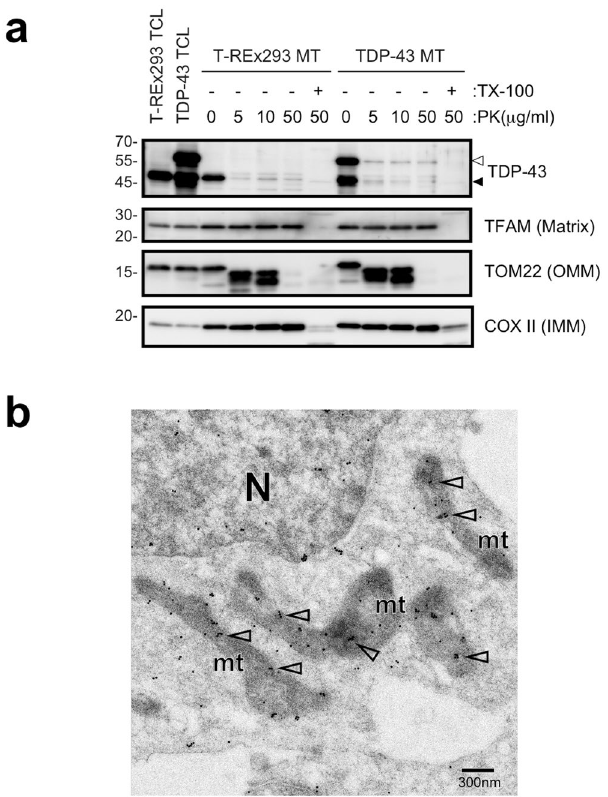
Figure 2. TDP-43 is localised in mitochondria in T-REx 293 cells. ( a ) Mitochondria prepared from T-REx 293 cells (T-REx 293 MT) or DAP-TDP-43 expressing T-REx 293 cells (TDP-43 MT) were treated with proteinase K (PK) in the presence ( + ) or absence ( − ) of Triton X-100 (TX-100). Proteins present in the outer mitochondrial membrane (OMM), inner membrane (IMM), or matrix were detected by WB with antibodies indicated on the right. Open arrowhead and closed arrowhead indicate DAP-TDP-43 and endogenous TDP-43, respectively. TCL; Total cell lysate. ( b ) Endogenous TDP-43 was detected within mitochondria of T-REx 293 cells by immunoelectron microscopy using anti-TDP-43 (60019-2-Ig). Open arrowheads indicate stained TDP-43. N, nucleus; mt,